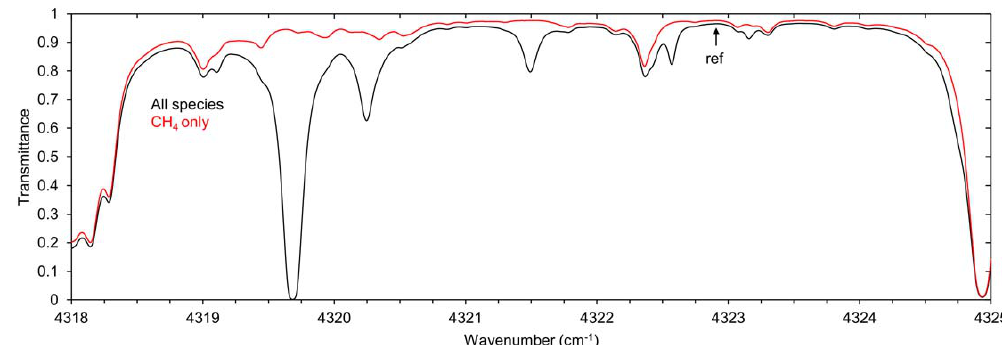
Fig. A3. Calculated spectrum of the CH 4 (2.3µm) reference region. This region is covered by the IR laser for CH 4 reference measurements (L3). CH 4 only – calculated for CH 4 only. All species – calculated including all relevant atmospheric species; almost all extra absorption is due to H 2 O. The label indicates the target reference (minimum absorption) position (cf. Table A1). Depending on actual frequency scan ranges, CH 4 might also be retrieved in this region. For conditions see Appendix